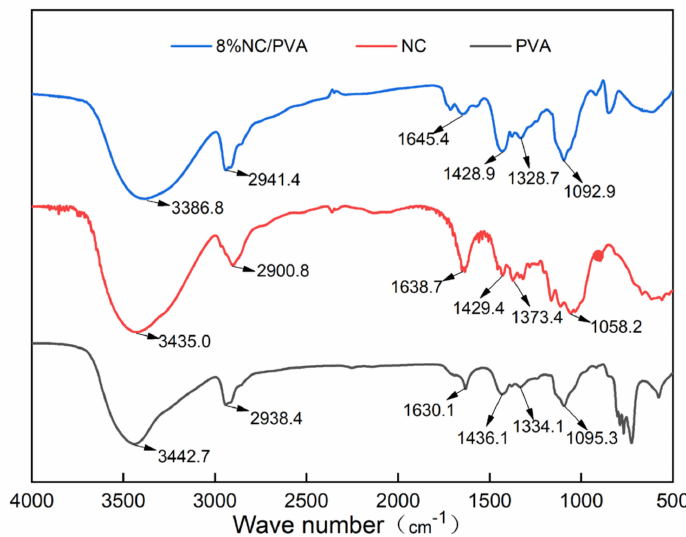
Figure 2. Infrared spectra of PVA, NC and PVA/NC composite